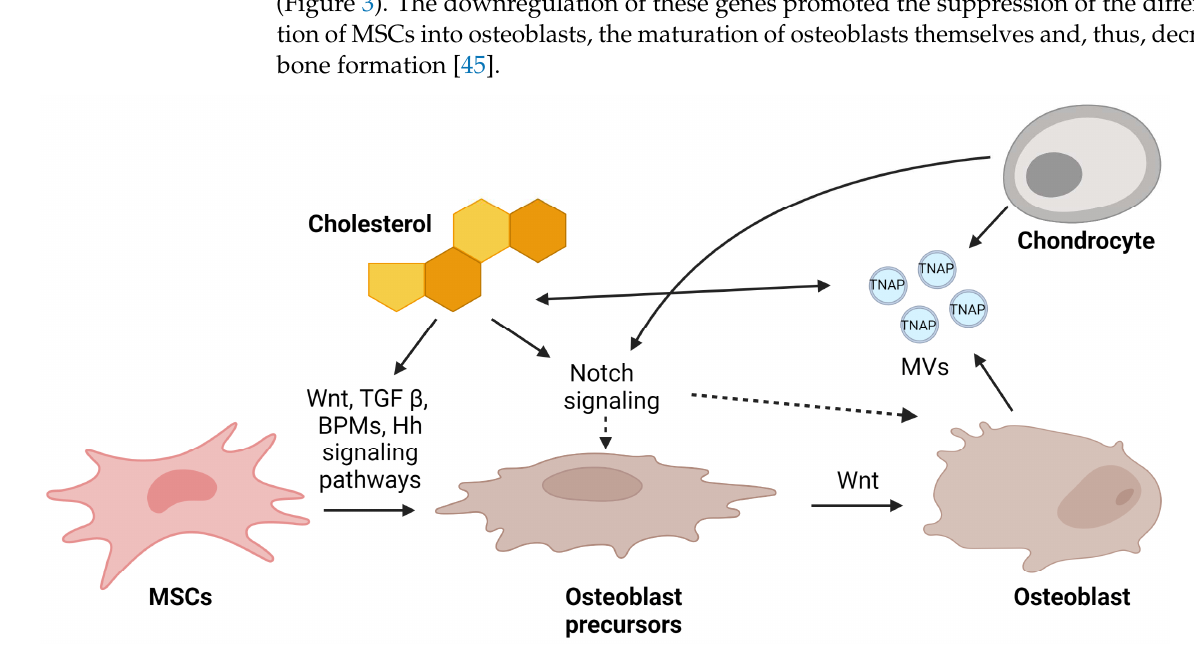
Figure 3. Possible mechanisms of regulation of osteoblastogenesis by cholesterol. In response to Wnt ligand, BMPs, and TGF β , bone-marrow-derived mesenchymal stem cells (MSCs) differentiate into mature osteoblasts. All these pathways were found to be regulated by cholesterol. On the other hand, sufficient release of matrix vesicles (MVs) by chondrocytes and osteoblasts ensures appropriate mineralization. Chondrocytes and cholesterol are connected via the Notch signaling pathway, and it is still unclear whether this directly affects pre-osteoblasts or osteoblasts. Nevertheless, this pathway is essential for proper bone formation. This figure was created using Biorender.com (accessed on 13 March